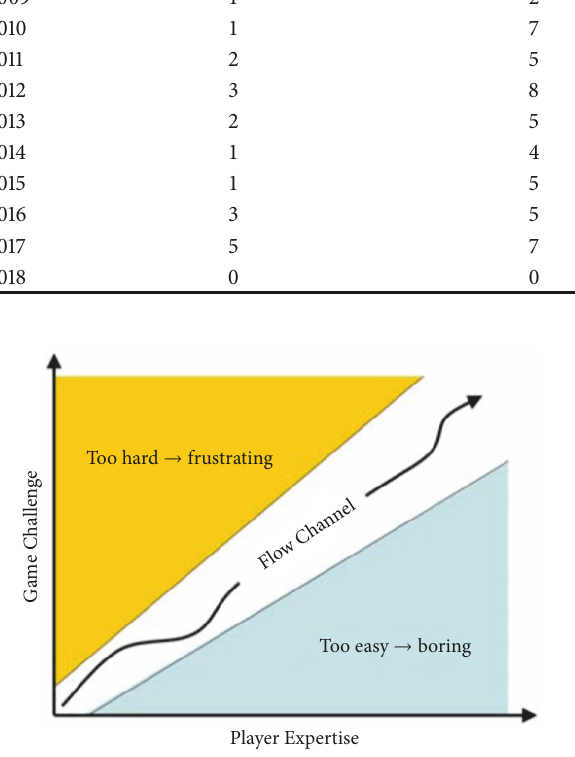
Figure 1: Flow channel concept proposed by